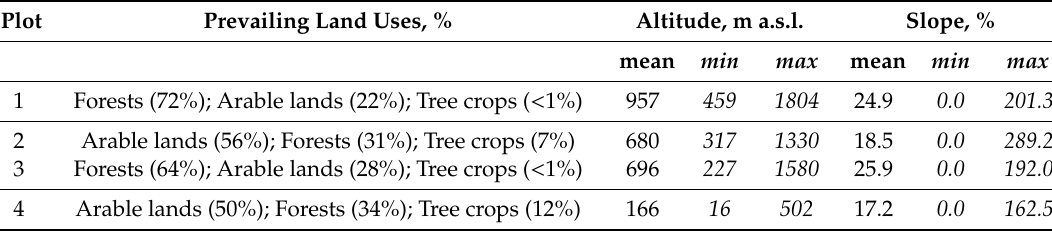
Table 1. Morphological and vegetation characteristics of the plot